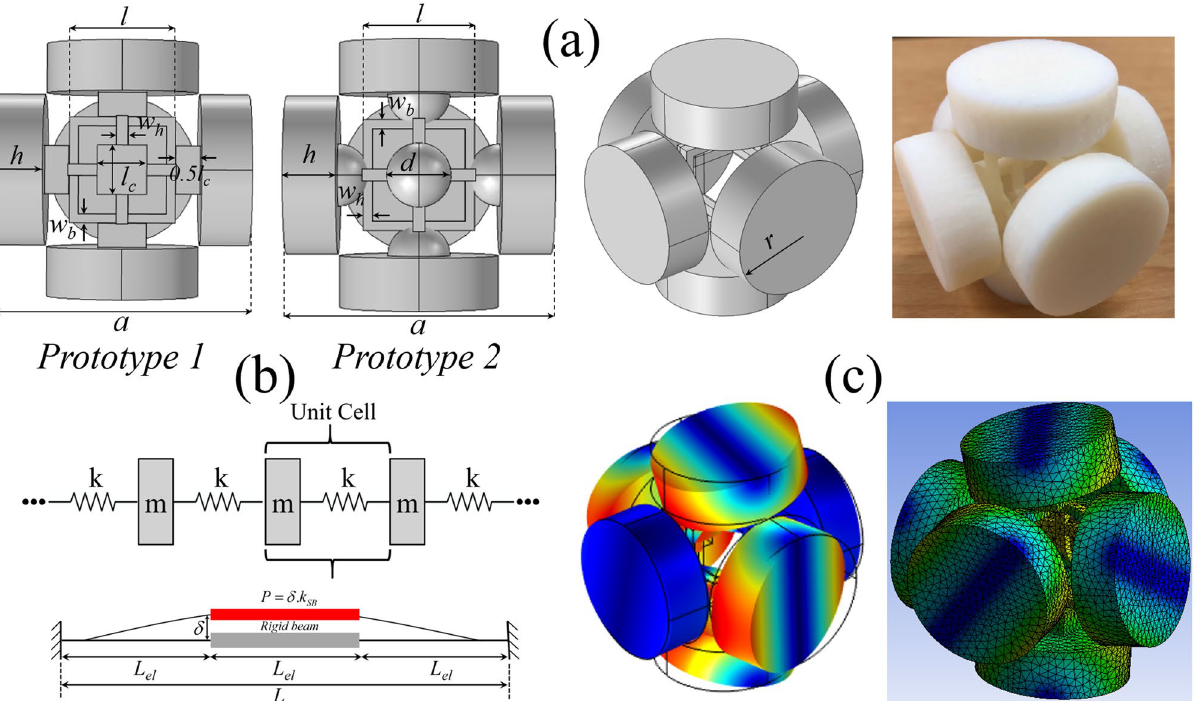
Figure 1. Proposed prototypes for 3-D phononic metastructures. ( a ) Schematic description for prototype 1–2 with 3-D printed sample. ( b ) Monoatomic mass-spring chain along with simplified beam structure. ( c ) Vibration mode for the lower bounding edge of first BG by COMSOL Multiphysics 5.4 (left) and ANSYS 2020 R1 (right). The analytical and FEA results comparison is presented in Table 1.